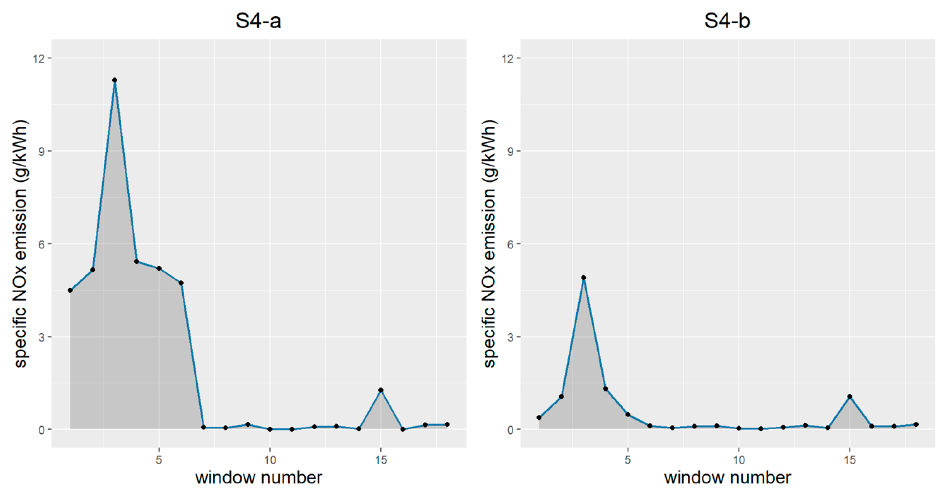
Figure 6. Sequence of specific NOx emissions per 10 min (left/right for the abnormal/normal case).